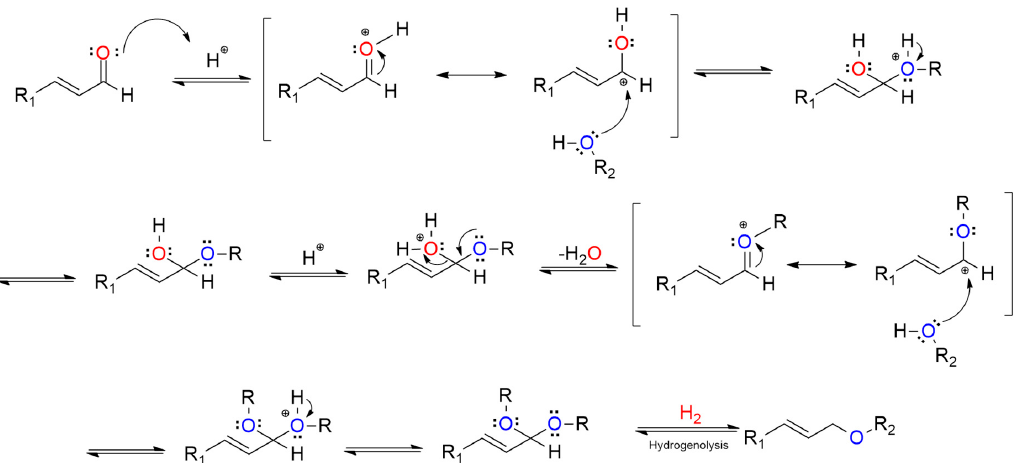
Scheme 2. Possible reaction pathway for hydrogenation transformation of unsaturated aldehyde